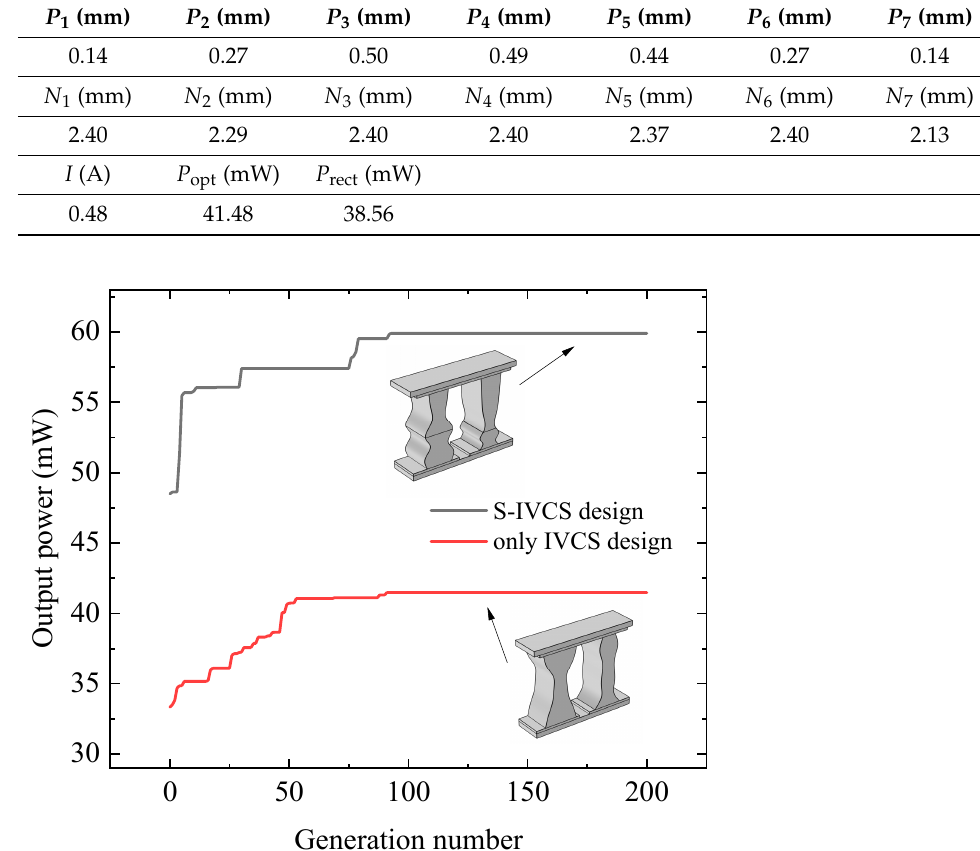
Table 4. The design parameters of the IVCS optimization.